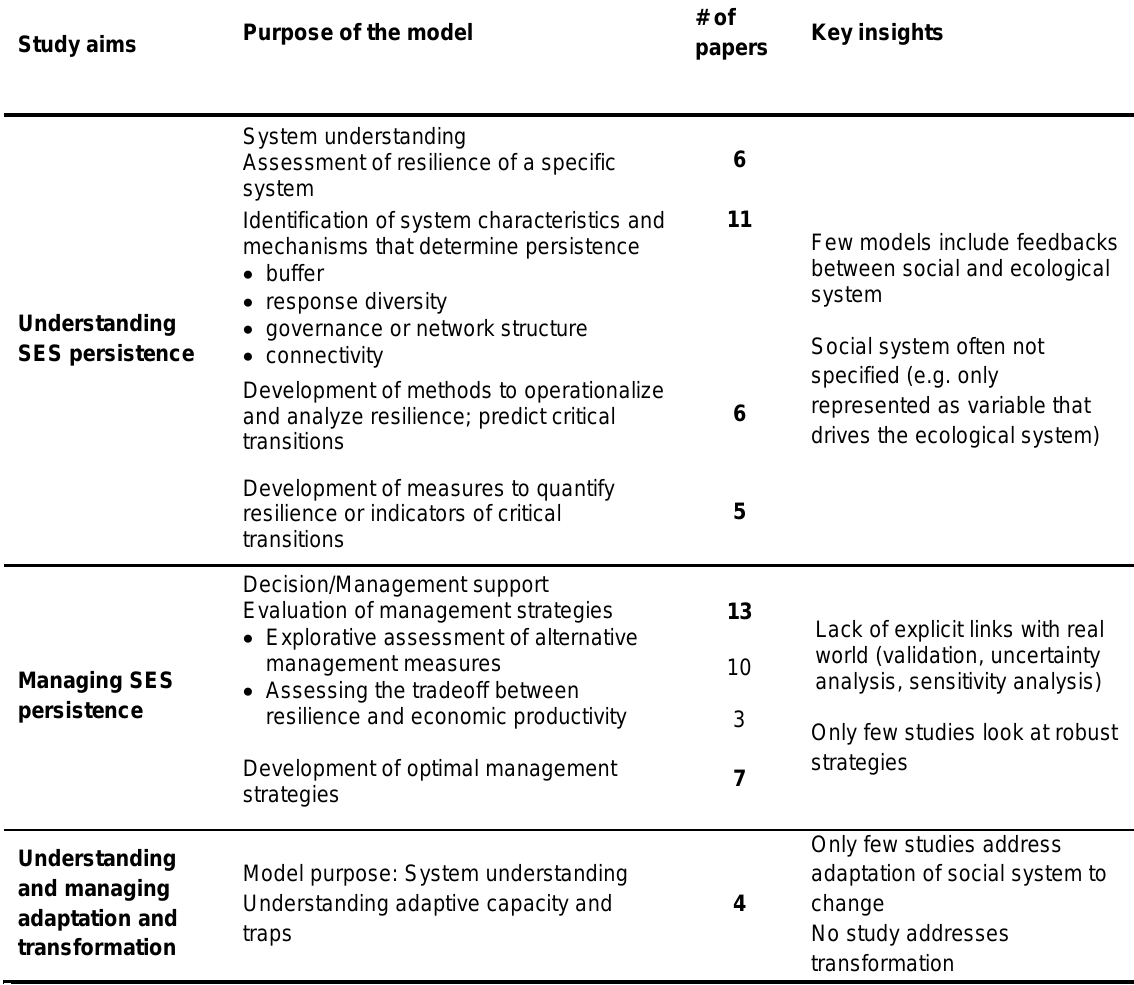
Table A1: Results of the review of 52 models of resilience from 1998-2011 Study